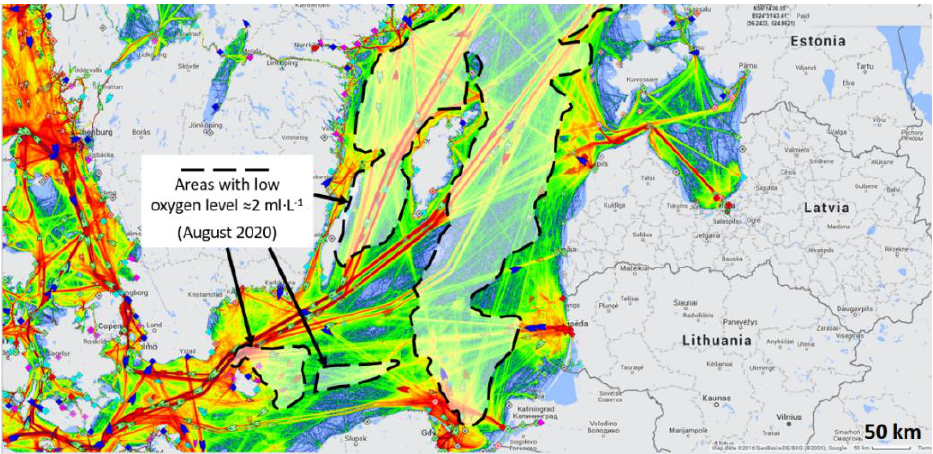
Figure 1. Ship traffic density map of Baltic Sea AIS, 2021, showing transport link development and availability [1] combined with marks indicating the areas with the lowest oxygen content (≈2 mL·L −1 ) near the seabed in the open sea [2]. Red lines demonstrate the highest traffic intensities.